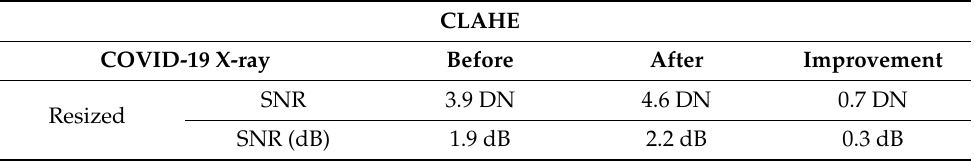
Table 3. Image quality comparison after CLAHE with SNR.